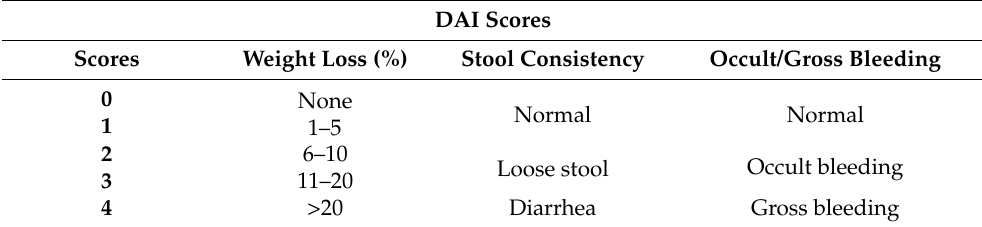
Table 1. Criteria used for disease activity index (DAI)